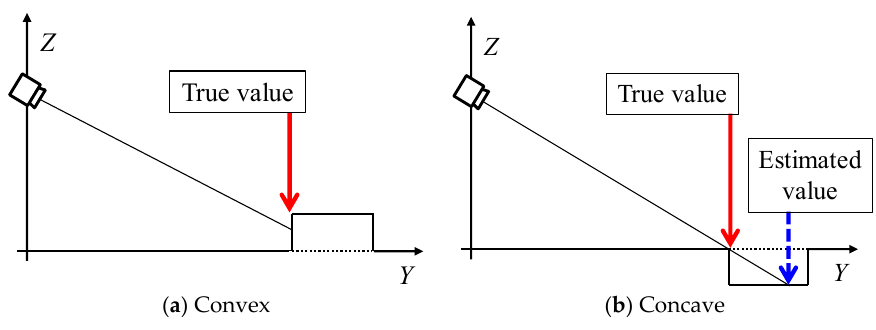
Figure 13. Reason of average error in the static hazardous object.